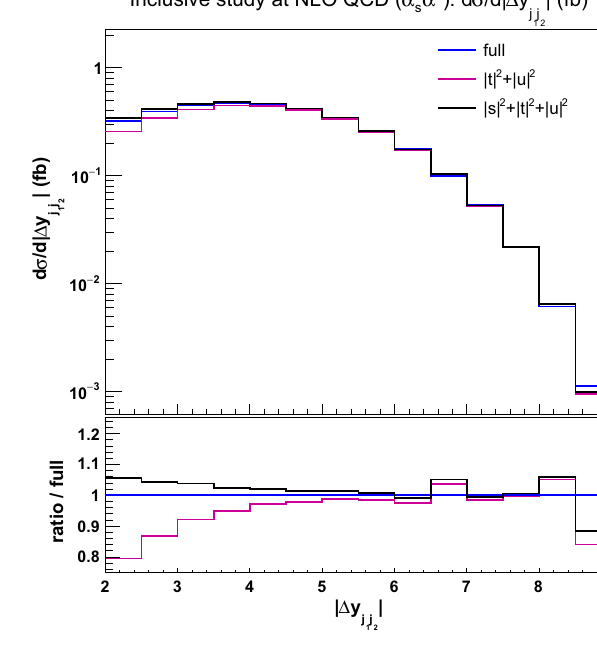
lower plots present all predictions normalised to MoCaNLO + Recola which is one of the programs that provide the full prediction. In addition to the cuts of Sect. 3.3, the VBS cuts take the values m jj > 200GeV and | Δ y jj | > 2